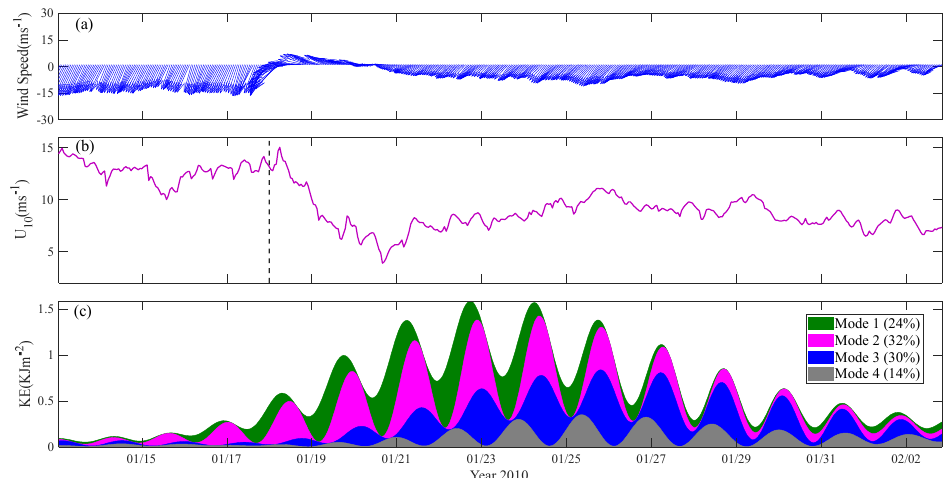
Figure 12. Time series of the wind ( a ), the wind speed amplitude ( b ), and the first strong NIKE ( c ) are marked by the red dashed rectangle in Figure 10. The values in the brackets indicate the percentage of the corresponding modal NIKE in the total NIKE (the combination of the four modes) during the corresponding observation period. The black dotted line denotes 0:00 on 18 January.